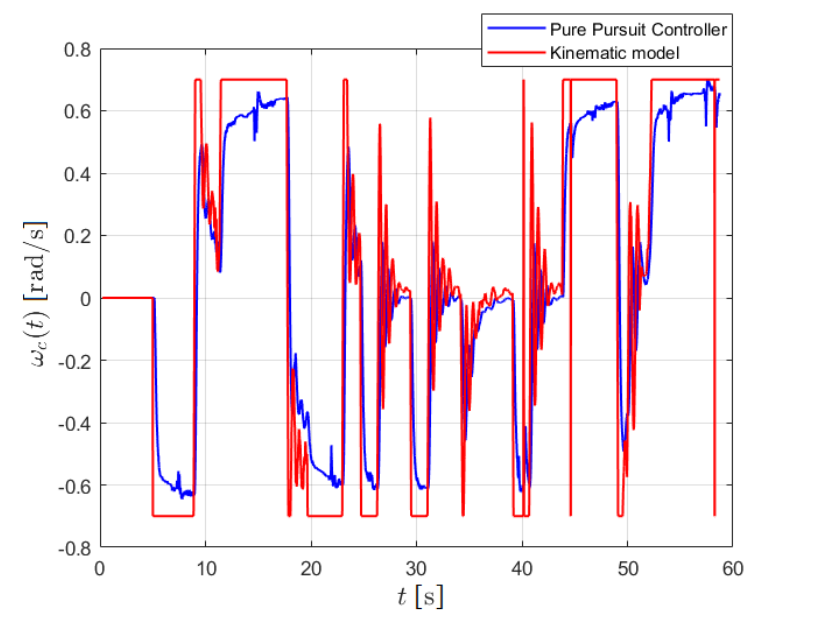
Figure 17. Angular velocity ω c ( t ) of the QBot 2e robot.